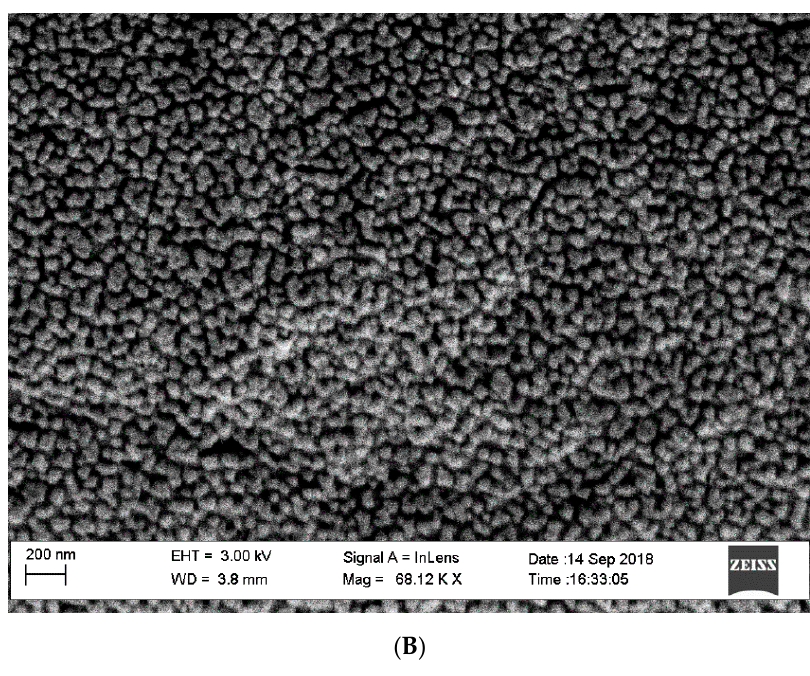
Figure 2. Electron micrographs (SEM) of GO-Tabs ( A ) before and ( B ) after polymerization.